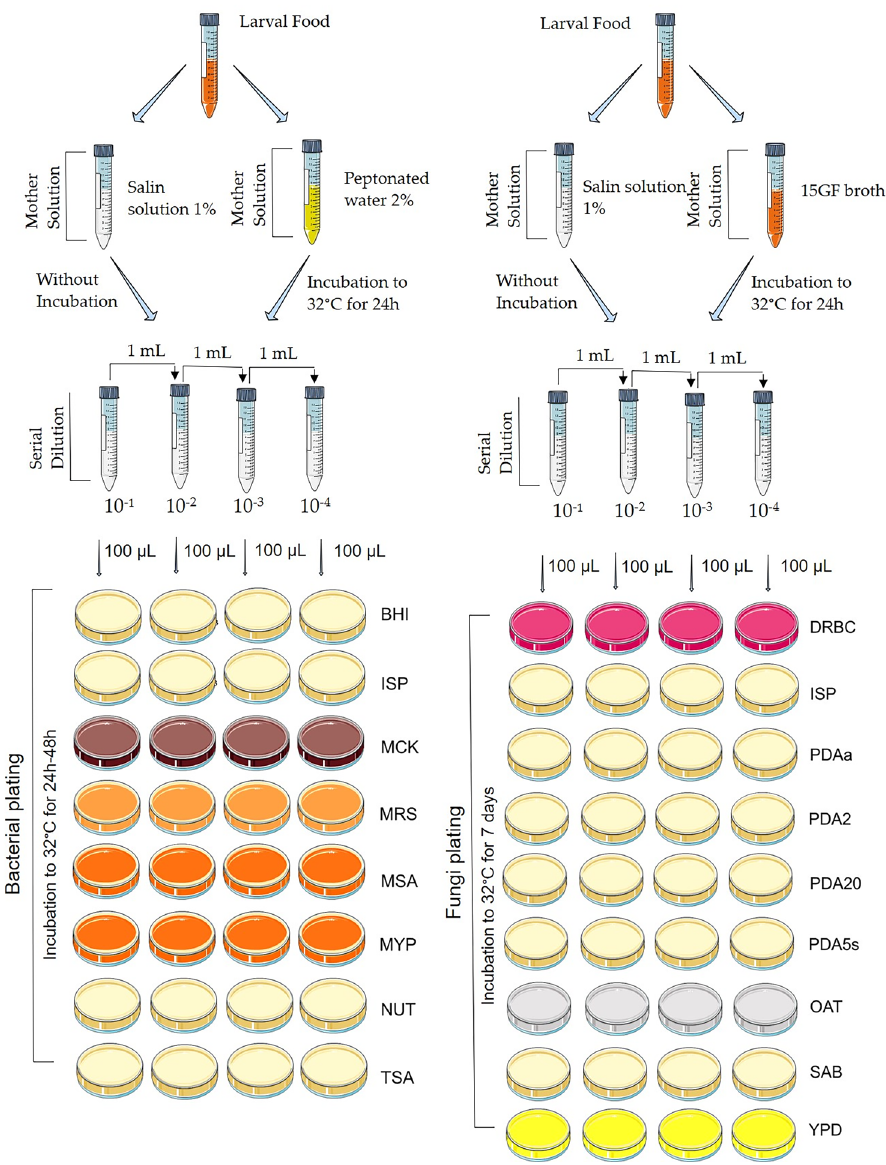
Figure 6. Methodology for cultivating larval food from four stingless bee species with different dilutions and culture mediums. Brain Heart Infusion (BHI), Nutrients (NUT), Tryptone soy agar (TSA), Man, Rogosa and Sharpe (MRS), Mac Conkey (MCK), Mannitol Salgado (MAS), Yeast Malt Agar (ISP), Potato Dextrose Agar 2% (PDA2) and 20% (PDA20) glucose, PDA acidified with tartaric acid (PDAa), PDA NaCl 5% (PDA5s), Oatmeal Agar (OAT), Yeast Extract-Peptone-Dextrose (YPD), DRBC (Dichloran Rose-Bengal Chloramphenicol) e Sabouraud (SAB). Images of representative method from ‘Smart Servier Medical Art’ (https:// smart. servi er.